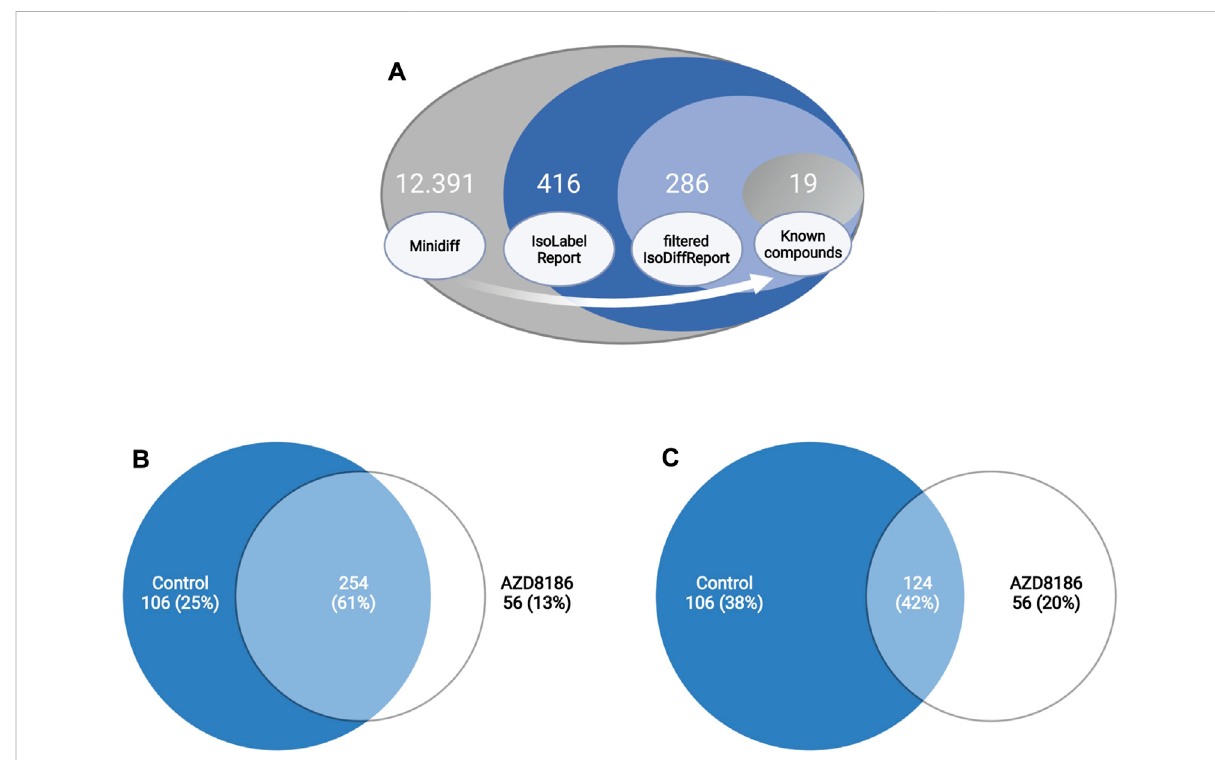
FIGURE 2 Differential labeling analysis of MDA-MB-468 cells treated for 24 h with vehicle or 0.5 µM AZD8186. Schematic display of the feature fi ltering procedure with the number of features obtained in the different processing steps (A) . Euler diagram of total labeled isotopologue groups in vehicle and AZD8186 treated cells (IsoLabelReport; Supplementary Table S4) (B) . Euler diagram of differentially labeled isotopologue groups between vehicle and AZD8186 treated cells ( fi lterIsoDiffReport; Supplementary Table S5) (C)